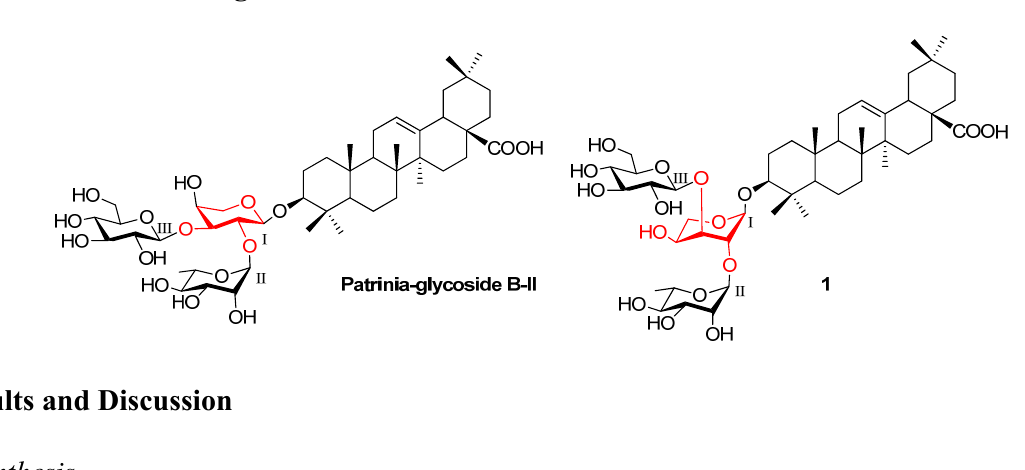
Figure 1. The structures of PB-II and its conformer 1